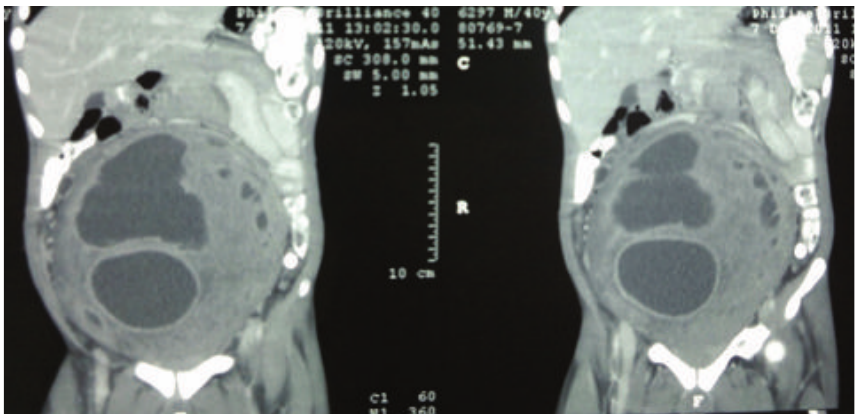
Figure 1: CECT (sagittal section) showing large solid-cystic mass occupying abdominopelvic region.